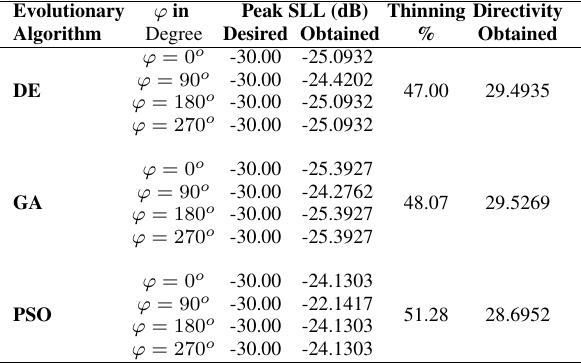
TABLE 4: Obtained values of design parameter in arbitrary